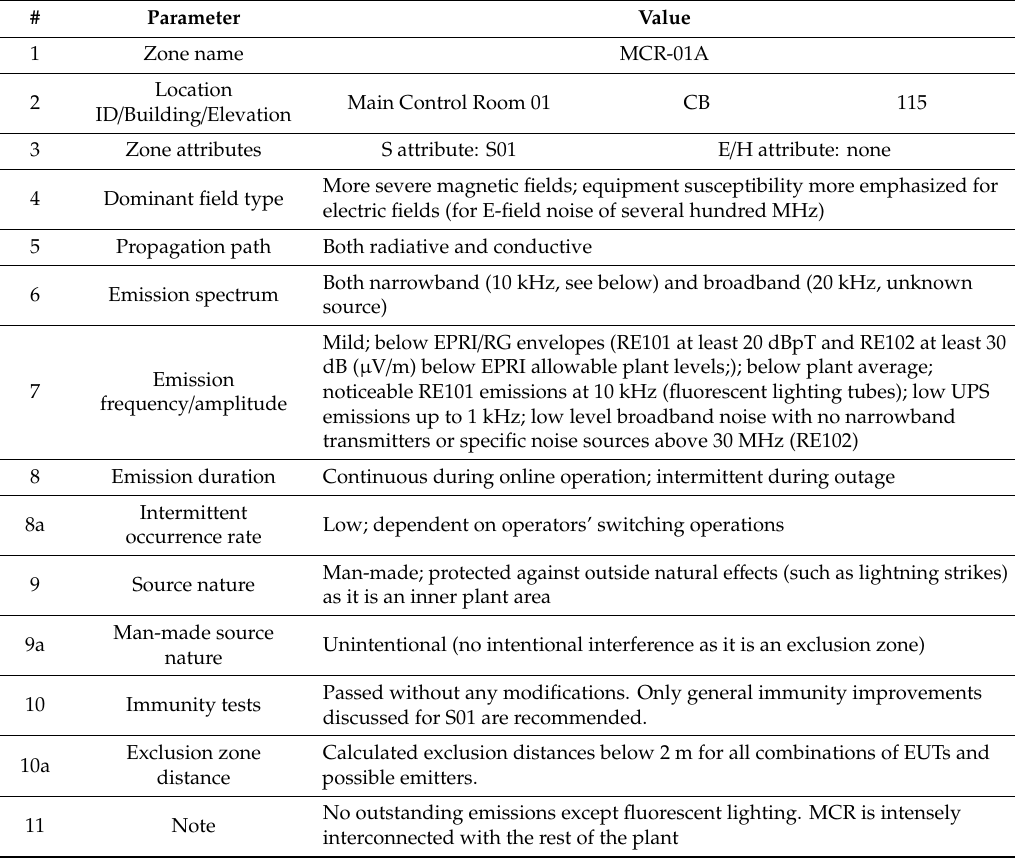
Figure 9. Example of the zone classification for a typical MCR. Table 2. Zone MCR-01A EMC